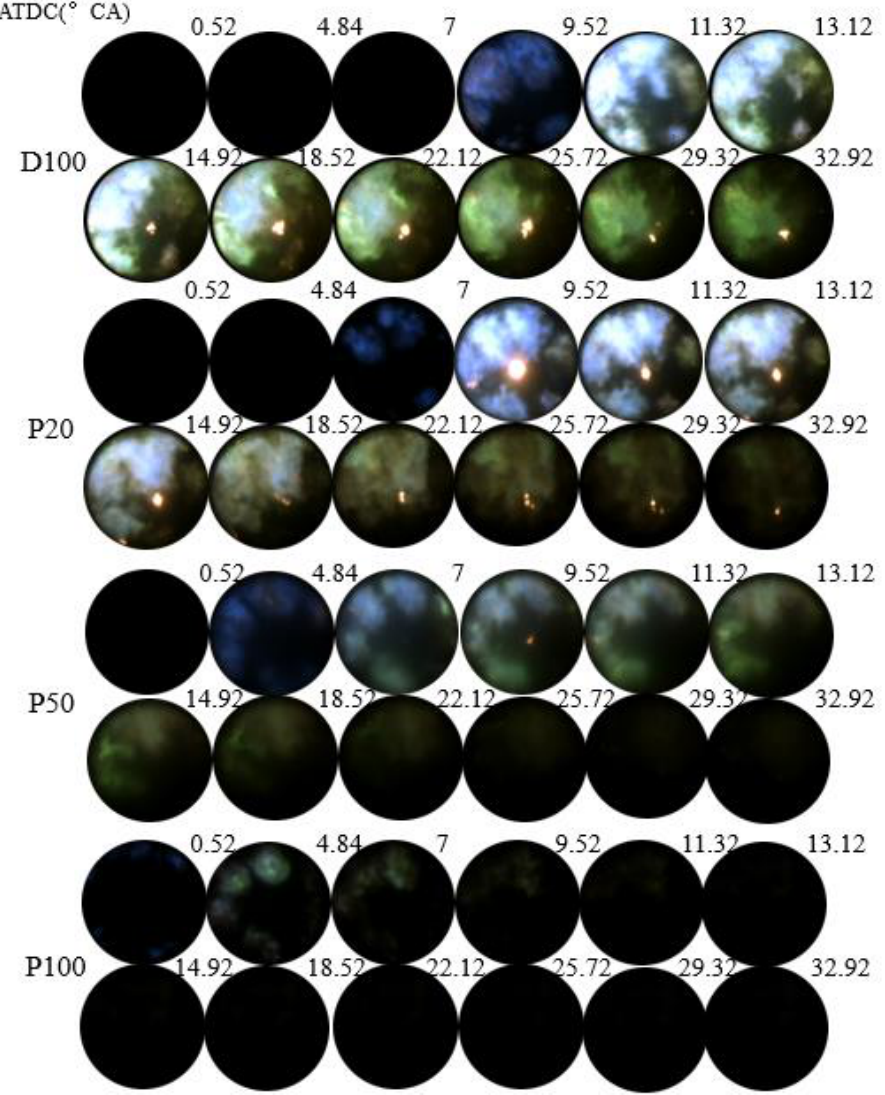
Figure 7. The combustion images (Injection pressure: 140 MPa; Injection timing: 6 ◦ CA